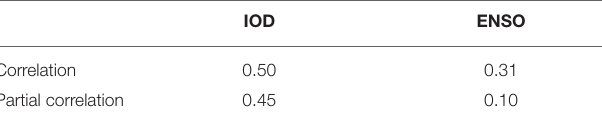
TABLE 1 | Temporal correlation coefficients (TCC) between PC1 and IOD/ENSO indices.